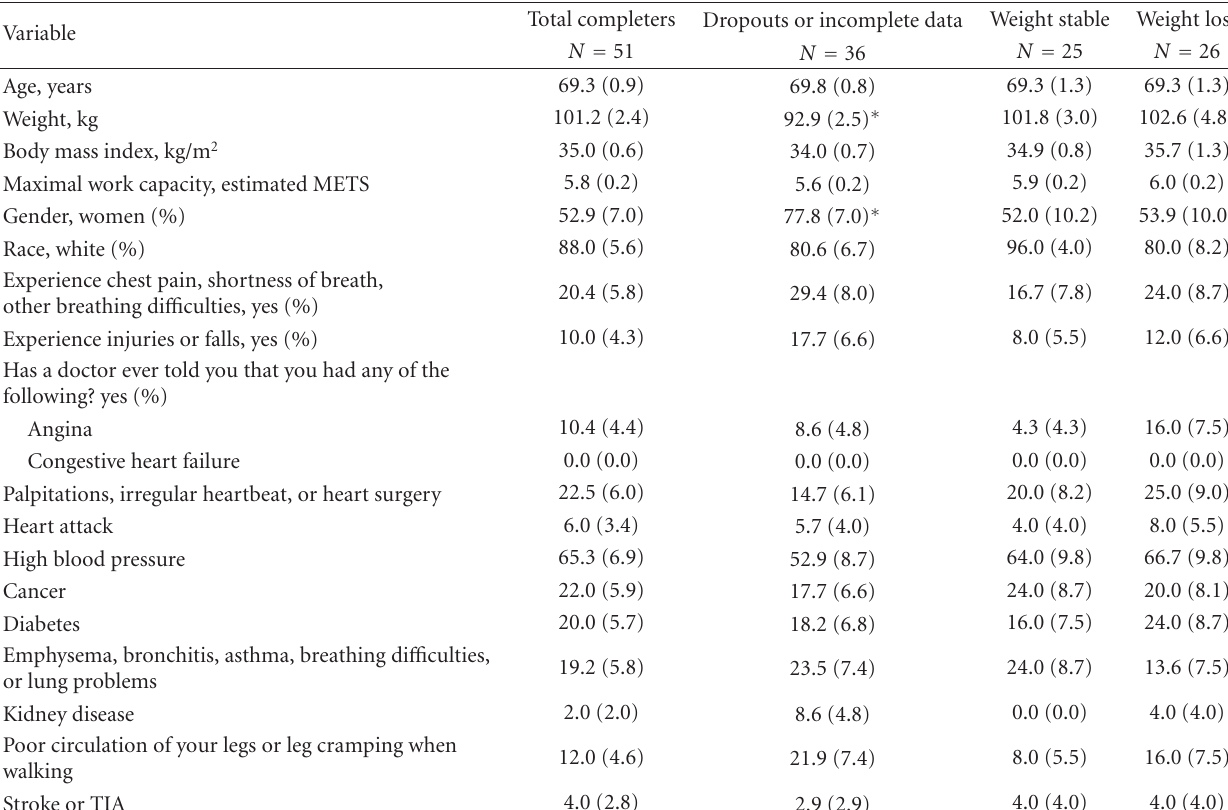
Table 1: Baseline demographics and medical history for participants categorized as total completers, dropouts, or incomplete data, and completers by randomized